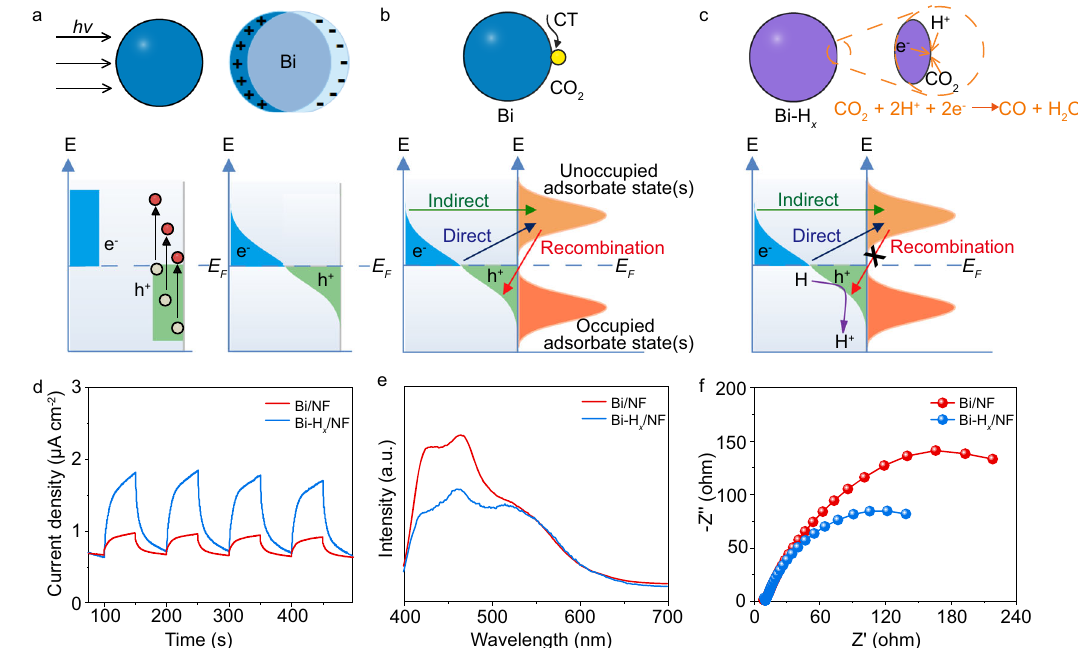
Fig. 5 Effects of hydrogen storage on the photoinduced CT property of Bi. a Generation and relaxation of LSPR-induced carriers under light irradiation. The blue areas above the Fermi energy ( E F ) and the green areas below E F represent the distributions of excited electrons and holes, respectively. b Schematic illustration of the transfer pathways of the LSPR-induced carriers in Bi through direct and indirect CT processes. c Graphical representation of the effect of the H stored in Bi-H x on improving the carrier separation in the CO 2 reduction reaction. d Photocurrent transient responses of Bi/NF and Bi- H x /NF catalysts under a 420-nm LED light irradiation at a bias of 1.07 V (vs. RHE). e The steady-state PL spectra of Bi/NF and Bi-H x /NF. f Nyquist plots of the Bi/NF and Bi-H x /NF catalysts at a bias of 1.07 V (vs.